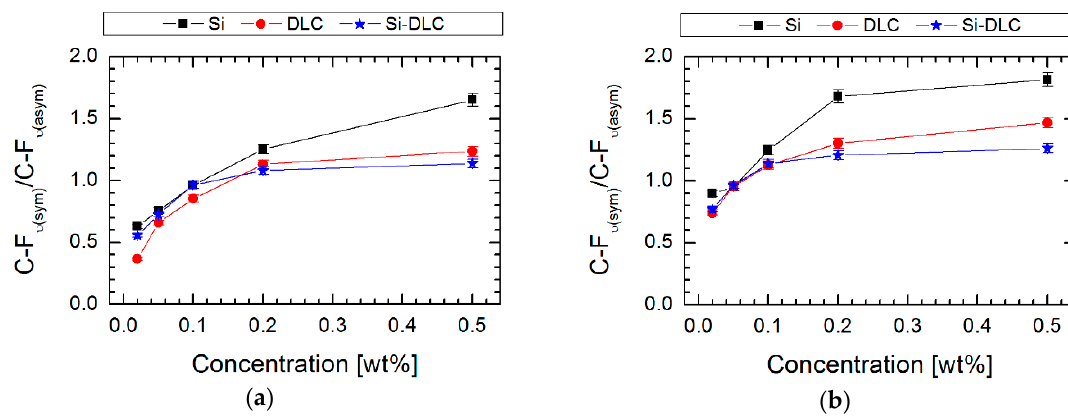
Figure 5. The area ratio of FTIR bands assigned to symmetric and asymmetric C-F stretching vibration versus concentration of perfluoroalkylsilanes used during the liquid phase deposition (LPD) process for ( a ) FPTS and ( b ) FDTS compounds.